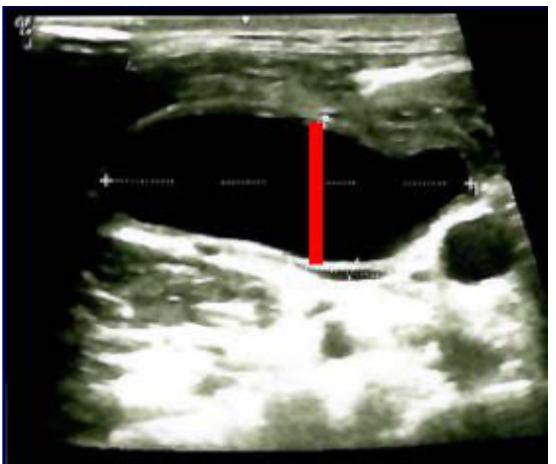
Figure 2. Neck ultrasound (right lateral area): hypoechoic, cystic- like, well-shaped mass of 6 by 2 by 4.5 cm (post-thyroidectomy capture: after 5 weeks since surgery before any additional intervention; red line represents the limits of the mass).